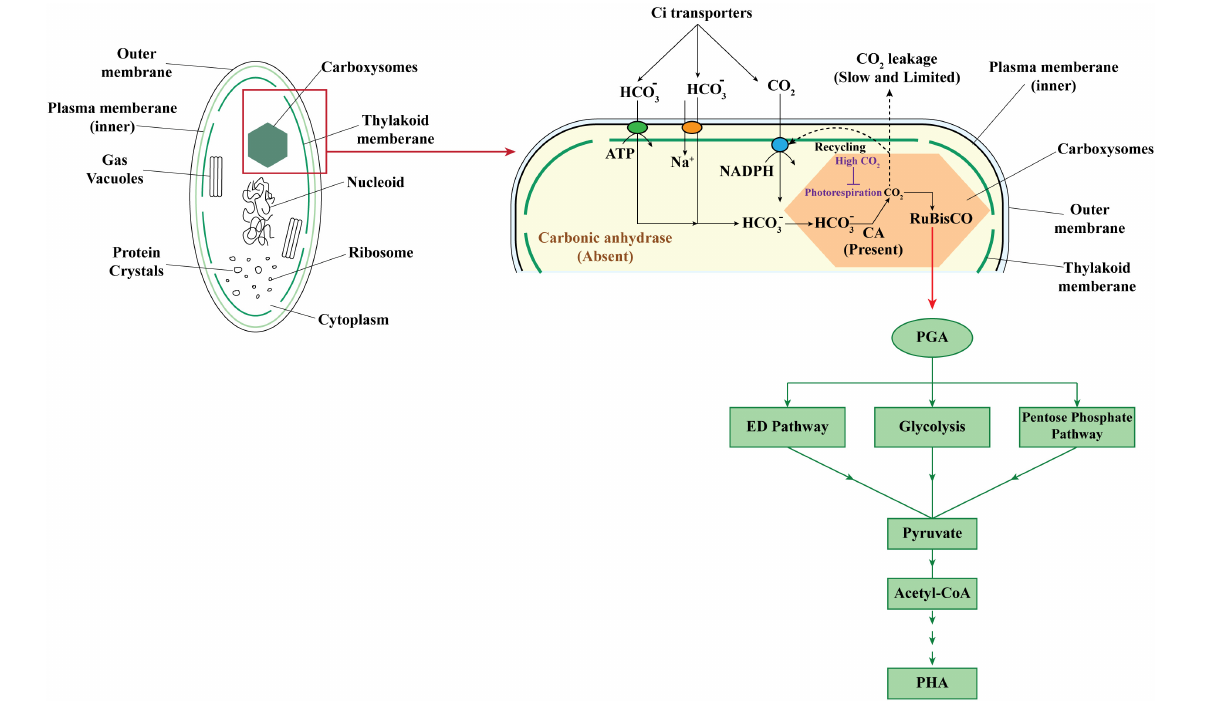
Frontiers in Bioengineering and Biotechnology |